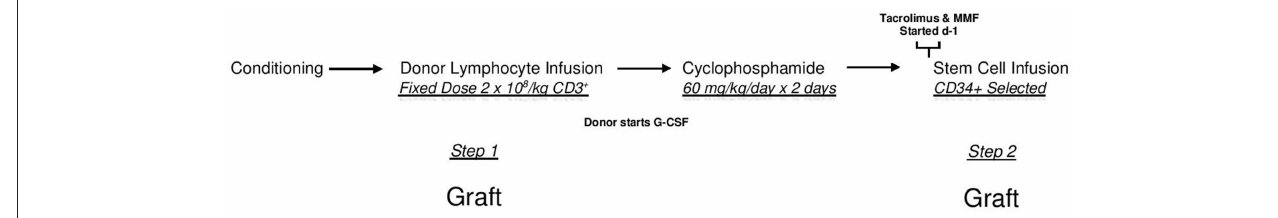
FIGURE 1 | The two step approach. After conditioning all patients receive an unmanipulated donor product containing a fixed dose of 2 × 10 8 /kg donor CD3 + cells (DLI-step 1 of transplant). Two days after the DLI, Cyclophosphamide is infused at a dose of 60 mg/kg/day × 2 days for bidirectional tolerization of lymphocytes. After a day of rest, a CD34 selected donor stem cell product is infused (step 2 of transplant). Conditioning regimens were myeloablative consisting of 12Gy total body irradiation ( n = 128); reduced intensity total of 78 patients consisting of Fludarabine, 2Gy total body irradiation, plus Cytarabine ( n = 13) or Thiotepa ( n = 45) or Busulfan ( n = 20); or non-myeloablative (Fludarabine plus 2Gy total body irradiation ( n = 10). In this regimen, patients receive identical tolerized T cell doses and graft vs. host disease prophylaxis. Lymphocyte polarization is avoided as donors begin growth factors after lymphocyte